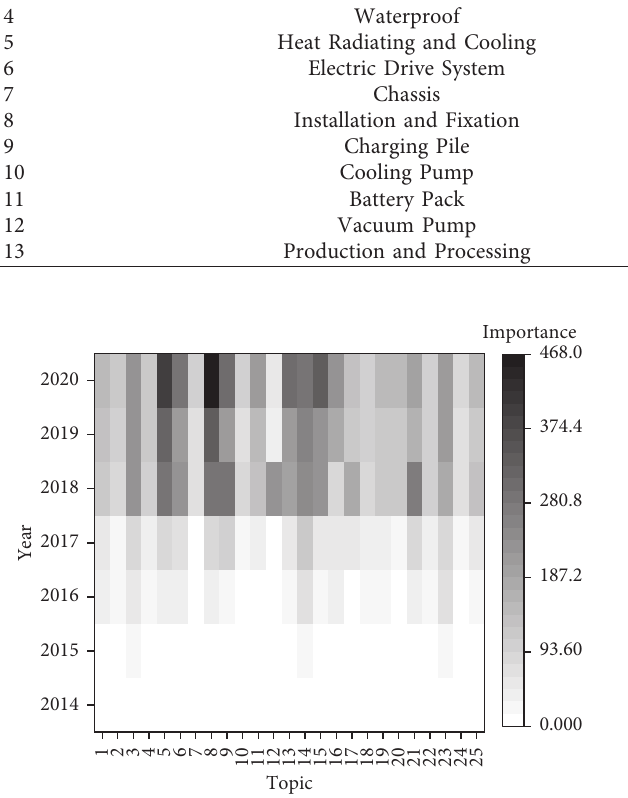
Figure 7: Map of the trend of importance of each technology topic.